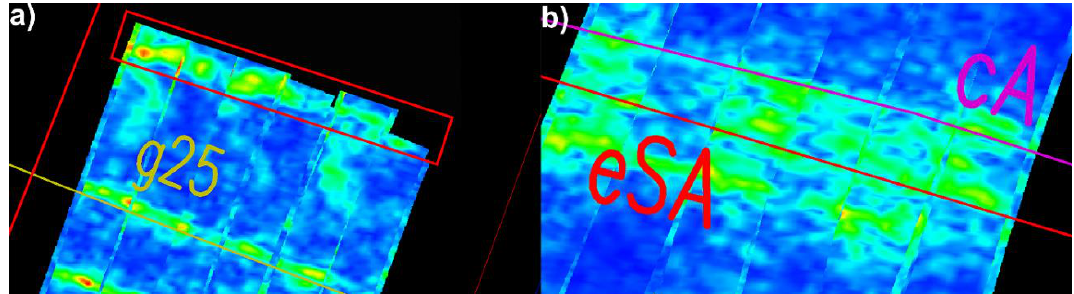
Figure 18. ( a ) The linear element identified in the echogram but not present on the map, ( b ) the C-scan view at the location of the heating and power network.